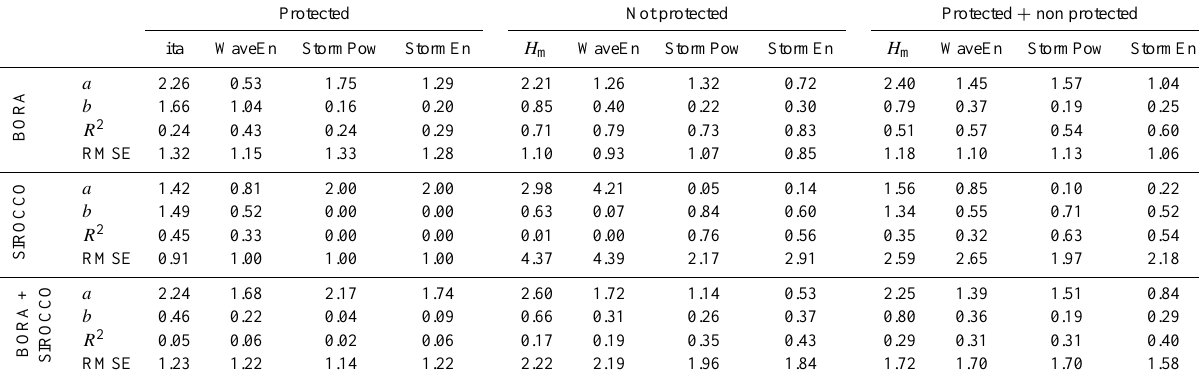
Table 3. Power law fit (cid:49)x = aY b for storms classified based on high ( > 300m 2 s 2 ) vs. low ( < 300m 2 s 2 ) total storm energy. Low energy High energy High + low energy H m WaveEn StormPow StormEn H m WaveEn StormPow StormEn H